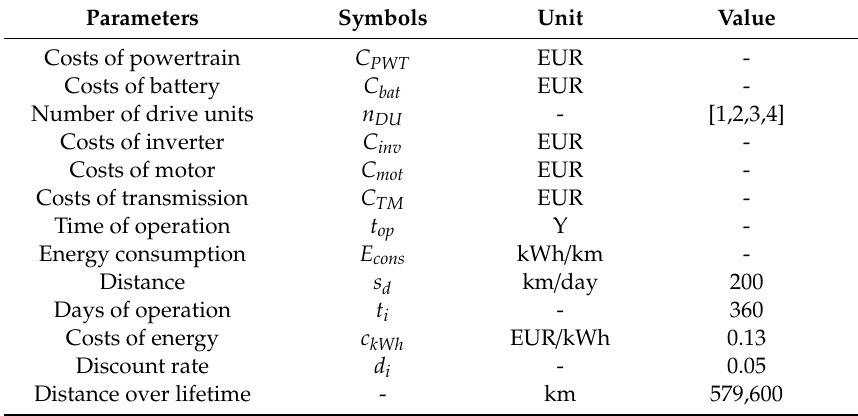
Table 2. Description of the symbols, their respective unit, and the value of the cost calculation [19].